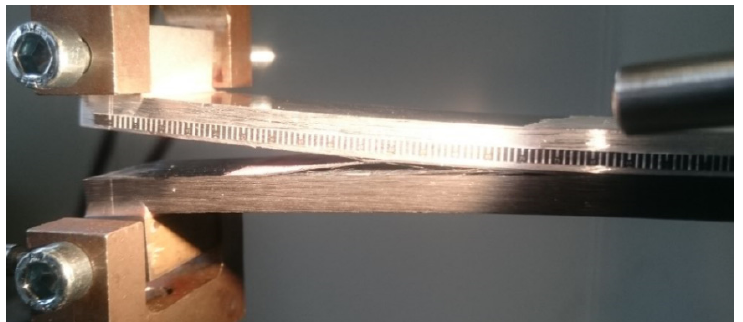
Figure 28. Detail of crack in the composite adherend (DCB_AF163_03 test) where it is evident that it converts into delamination after a certain propagation.